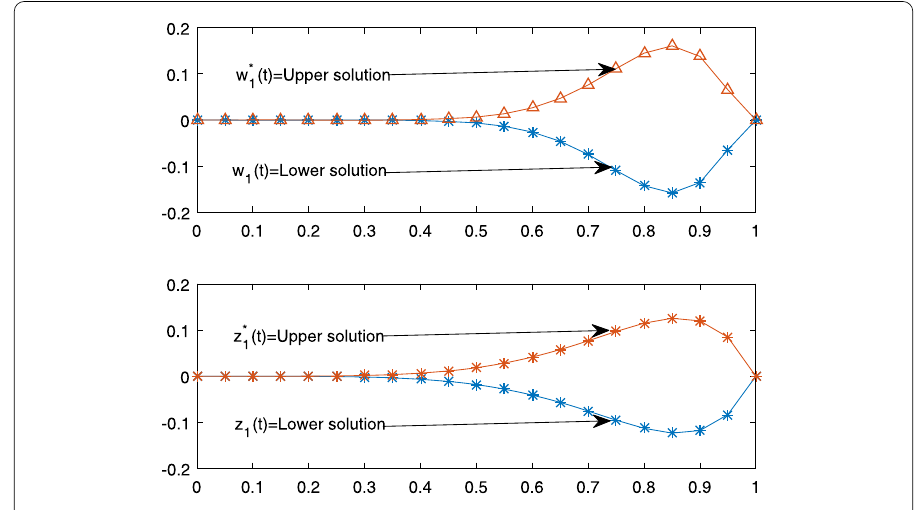
Figure 5 A line graph of the solutions of Example